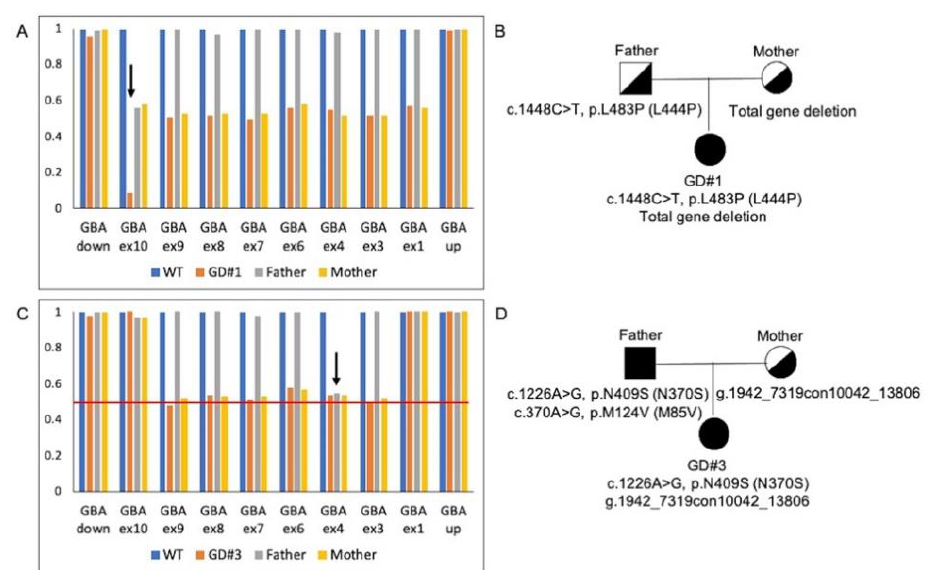
Figure 2. Co-segregation analysis performed by MLPA in GD#1 and GD#3’s family. ( A , C ) Normalized bar charts of GBA gene copy number patterns in the proband (orange bars), the mother (yellow bars) and the father (grey bars). Data were normalized to those of healthy controls (blue bars). ( A ) GD#1’s family co-segregation analysis. The black arrow indicates the absence of the peak corresponding to the GBA exon 10 probe in the proband. The father presented a half-reduced exon 10 relative peak height, while the mother displayed a half-reduced relative height of all GBA exons. ( B ) Family pedigree showing genotypes in GD#1. ( C ) GD#3’s family co-segregation analysis of the AH006907.2: g.2094con10194 recombinant allele. The black arrow indicates a half-reduced relative peak height corresponding to the GBA exon 4 probe in GD#3’s father. The mother presented a half-reduced relative height of exons 3 to 9. ( D ) Family pedigree showing genotypes in GD#3.